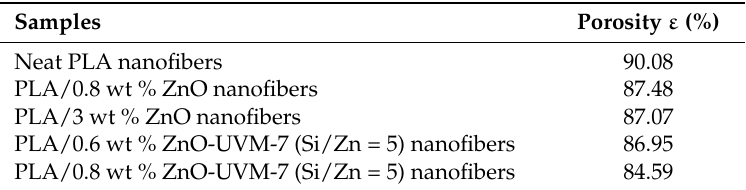
Table 2. Porosity of PLA nanofiber scaffolds produced by the electrospinning process, measured by the liquid intrusion method at room temperature.